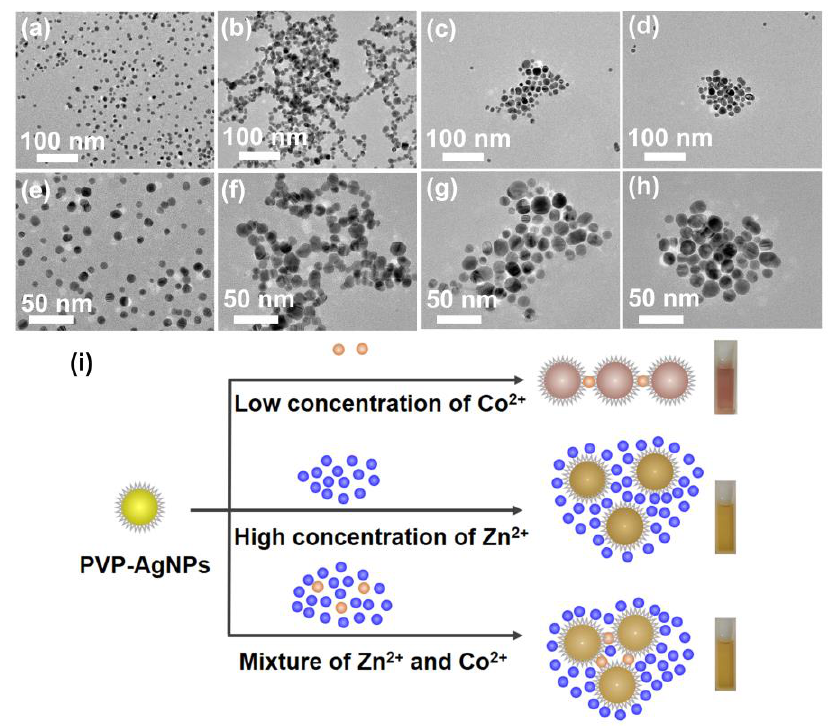
Figure 5. TEM micrograph and size distributions: ( a , e ) PVP-AgNPs in pure water free of metal ions; ( b , f ) PVP-AgNPs in the presence of 2 mg/L Co 2+ ; ( c , g ) PVP-AgNPs in the presence of 50 g/L Zn 2+ ; ( d , h ) PVP-AgNPs in the co-existence of 2 mg/L Co 2+ and 50 g/L Zn 2+ . ( i ) Illustration of the particle behaviors of PVP-AgNPs in various solutions.